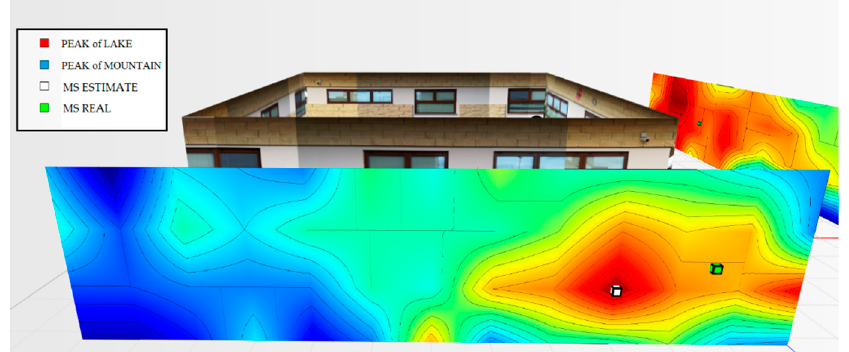
Figure 28. Power level for wall 1 related to the terminal located in the room to the right at 1.4 m.